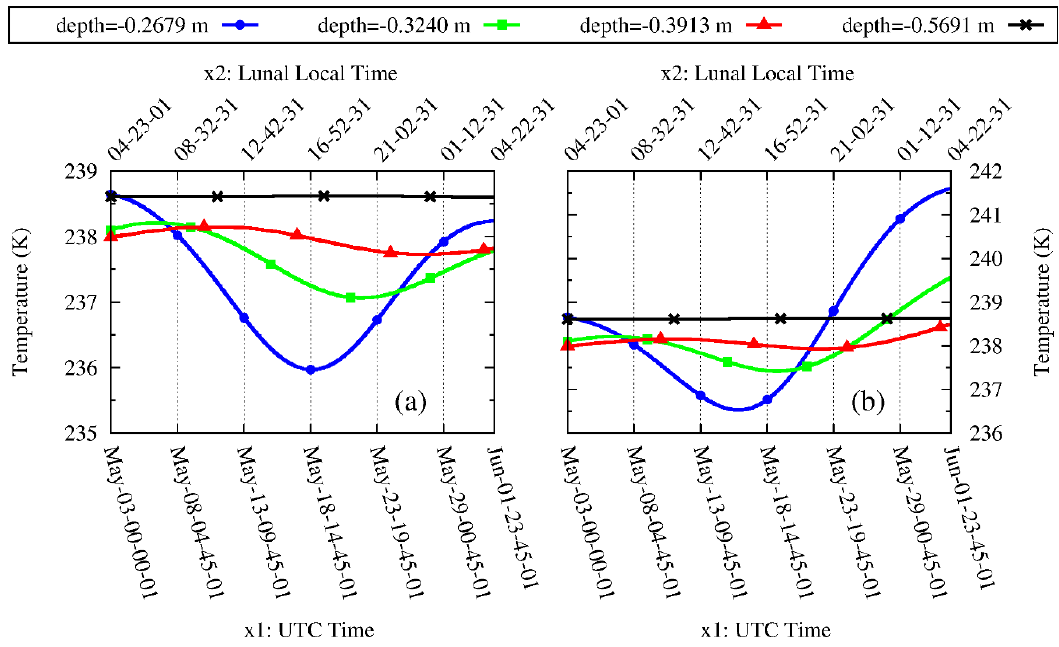
Figure 10. Subsurface temperature variations at the two landing sites [2]. ( a ) denotes variations for the red square points, and ( b ) represents those for the red star in Figure 1. The border-down x1 represents UTC time, while the border-up x2 denotes lunar local time.